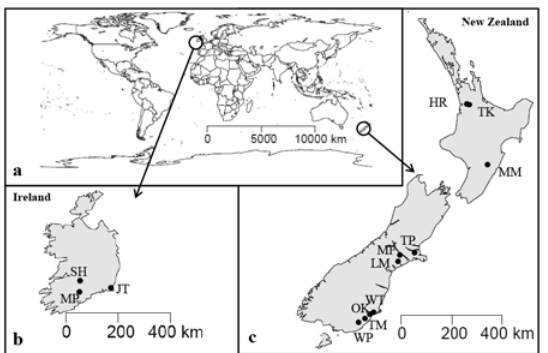
Fig 1. Geographical location of soil samples. Map showing origin of soil samples used in the study (a) world map, (b) Ireland [Moorepark (MP), Johnstown (JT), Solohead (SH)] and (c) New Zealand [Warepa (WP), Otokia (OT), Wingatui (WT), Tokomairiro (TM), Mayfield (MF), Lismore (LM), Templeton (TP), Manawatu (MM), Horotiu (HR), Te Kowhai (TK)]. The map was generated using open source “ R-programme (packages ‘ maps ’ and ‘ mapdata ’ ) ”